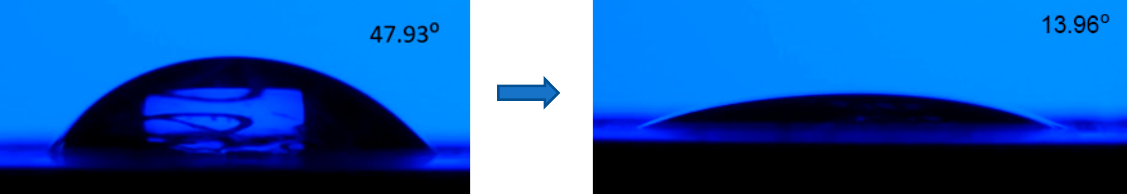
Figure 14. Aberration in contact angle measurement of the sample design type B (no. of repetition 1/frequency 40 kHz).